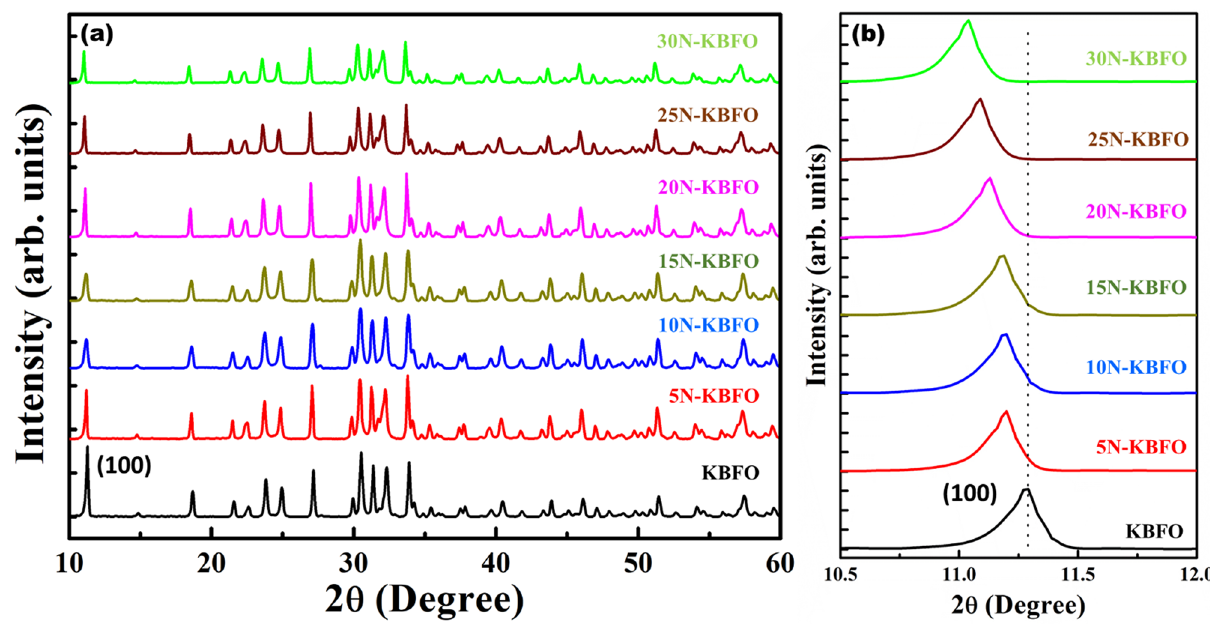
Figure 1. ( a ) XRD patterns for KBFO with various N-doping concentrations ( b ) Magnified view of (100) plane in XRD showing a shift towards lower